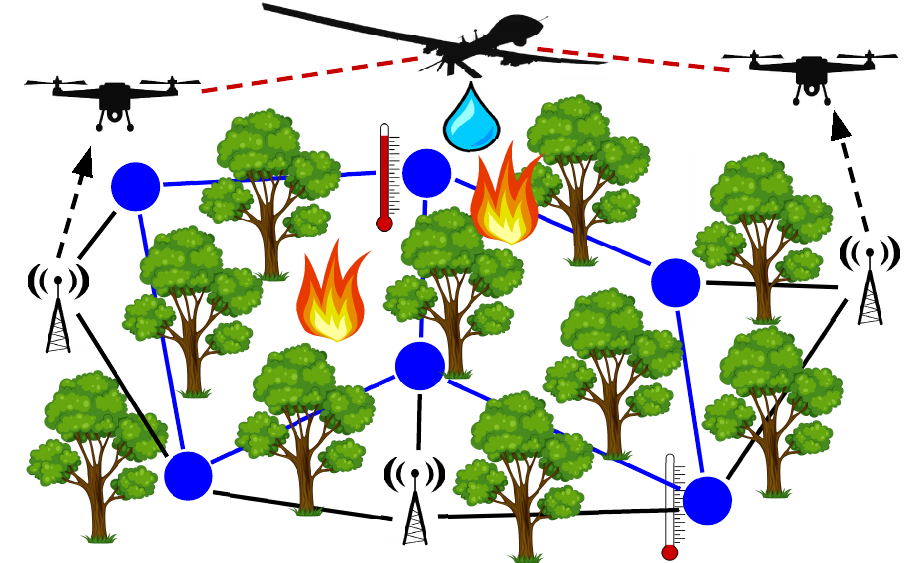
Figure 1. Application of a wireless sensor network in forest